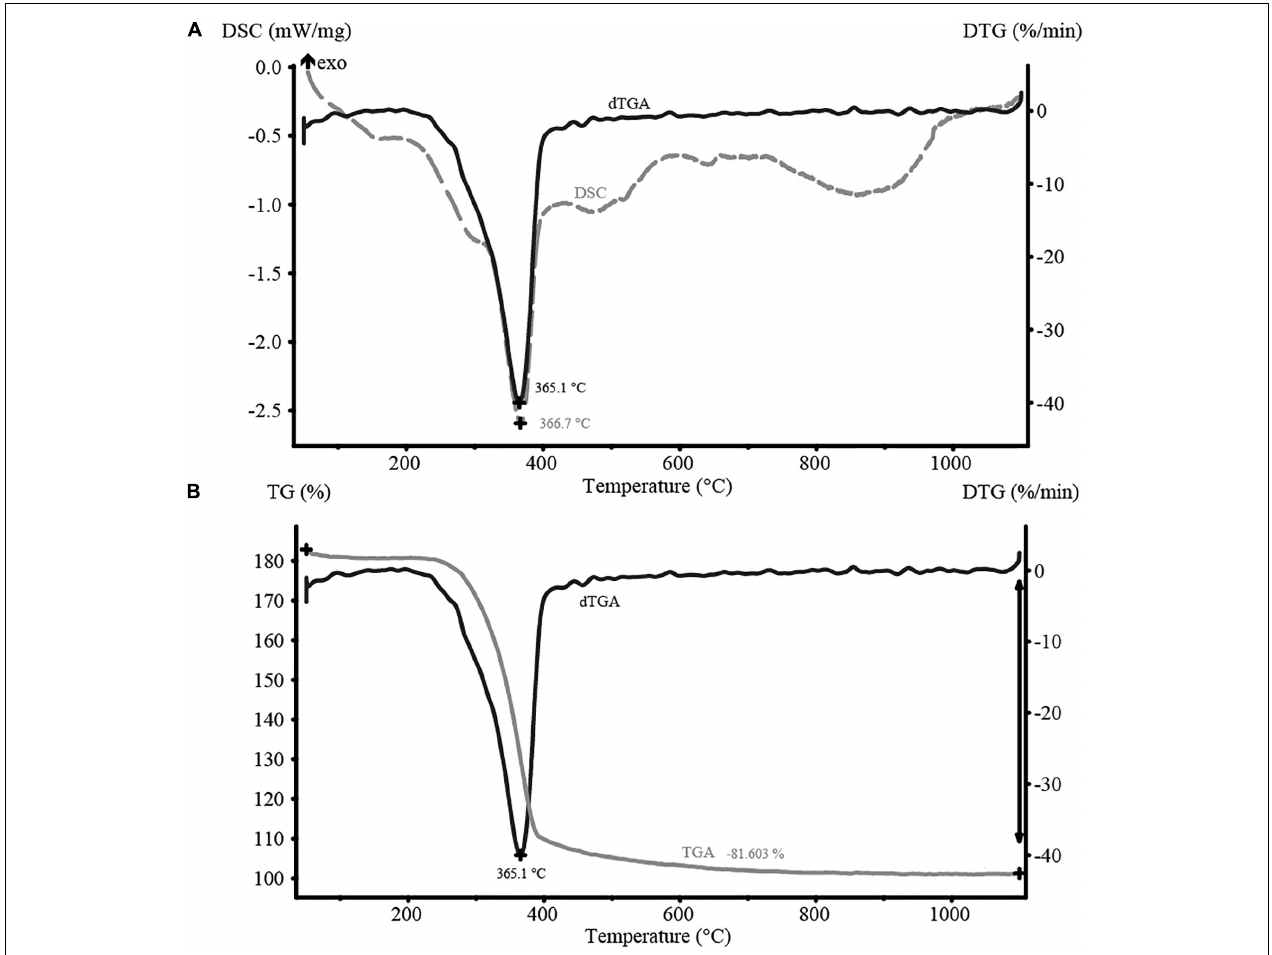
FIGURE 12 | TGA and DSC curves with temperature for the Albizia tree wood sample. (A) DSC curve shows a trough at the same temperature as dTGA which means that most of the heat is being produced by volatilization. (B) TGA curve corresponding to mass loss, which is correlates with devolatilization. Most of the mass (mean − 81%) is lost at low temperature (365.3 ◦